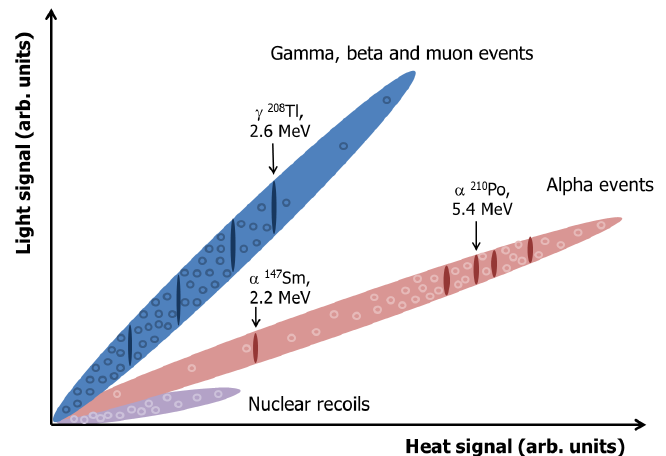
Figure 1. Schematic presentation of particle-dependent distributions of light signals measured by a photodetector in coincidences with the energy releases detected by a crystal scintillator-based bolometer. Circles represent individual events, which can form peaks shown as dark ovals on the β ( γ , µ ) and α bands. The light output induced by highly ionizing particles (alpha particles, nuclear recoils) impinging the scintillator is suppressed (quenched) with respect to the one induced by electrons (as well as γ quanta, cosmic-ray muons) of the same energy. Therefore, particles with different ionization properties become separated on such light vs. heat scatter-plot. The separation is more profound at higher energies, with increased amount of the detected scintillation